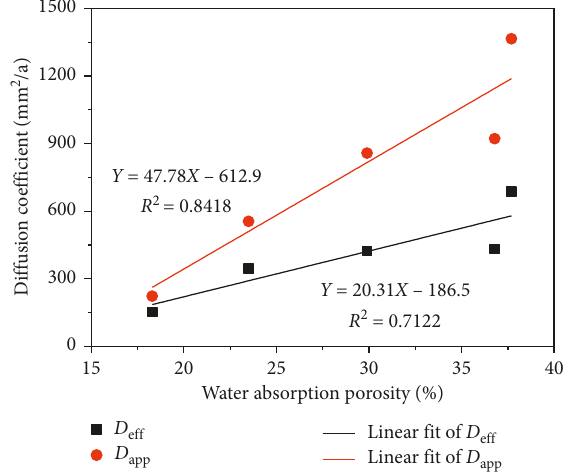
Figure 12: Relation between diffusion coefficient and water ab- sorption